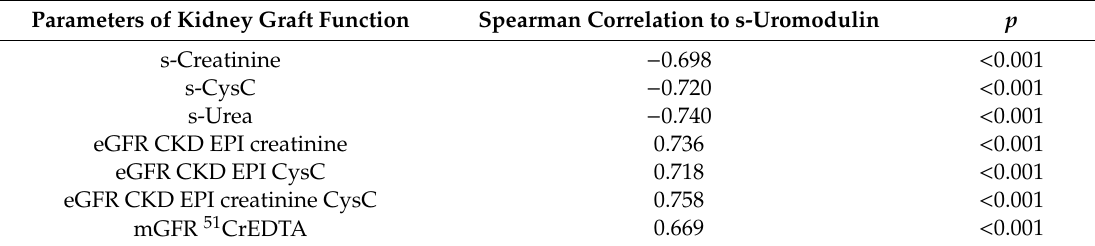
with Chronic Kidney Disease Epidemiology Collaboration study formula with s-Creatinine and s-